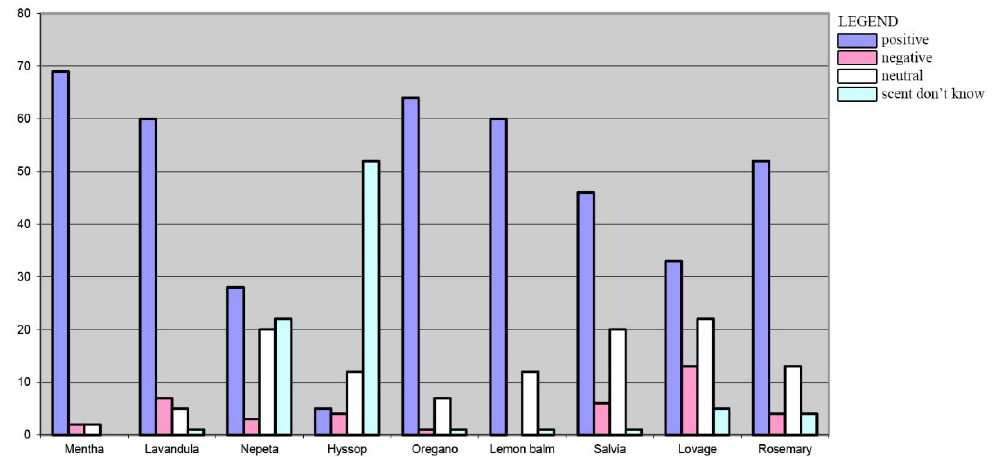
Figure 2. Results showing the perception of the smell of each herb as reported by respondents.